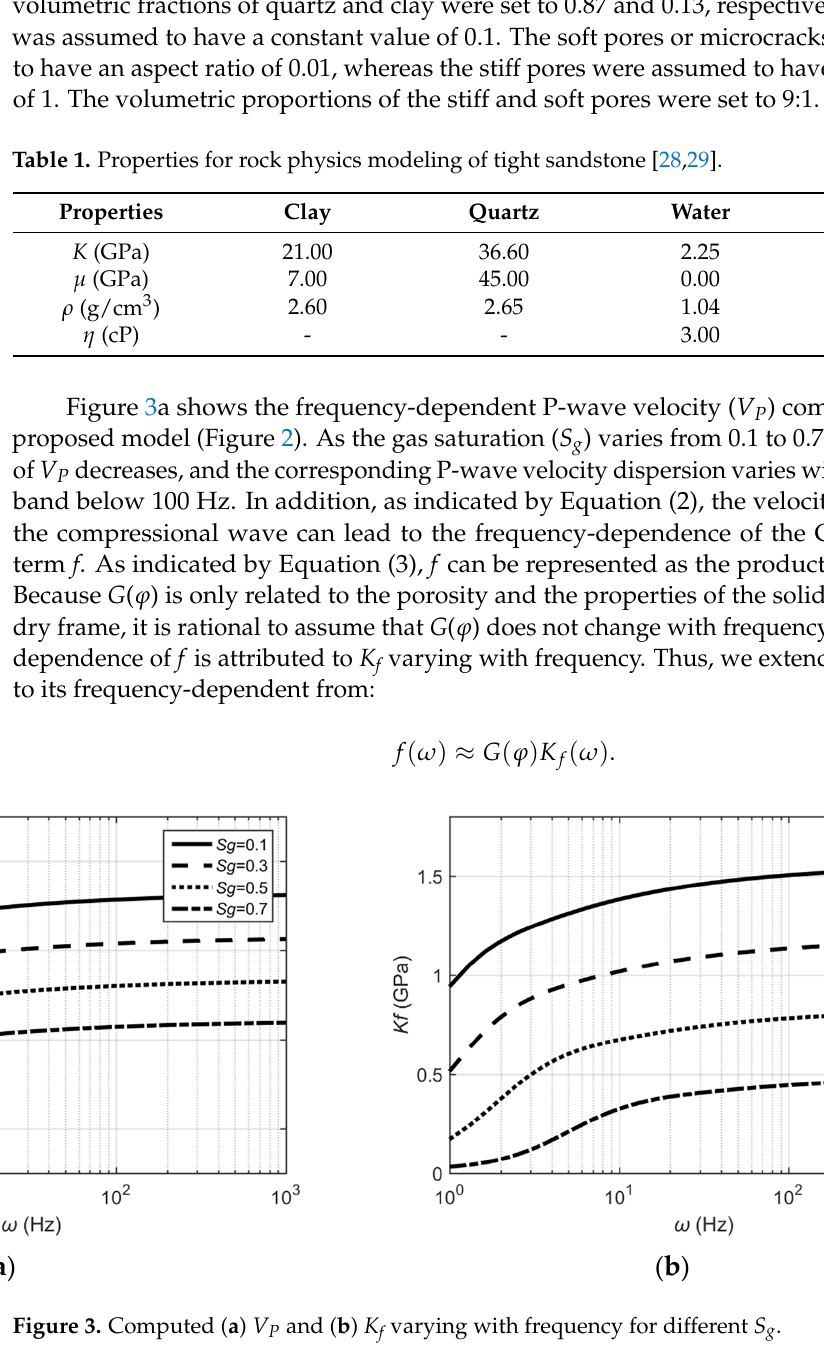
( b ) Figure 4. Computed ( a ) Δ V P / V P and ( b ) Δ K f / K f varying with frequency for different S g . In this study, we assumed that the fluid dispersion attribute was associated with the wave ‐ induced fluid flow described by patchy saturation theory [30]. However, depending on the characteristics of tight sandstones in specific areas, complex poroelastic behaviors in tight sandstones may be described by different theories, including the multi ‐ scale frac ‐ ture model [10,11] and the double ‐ porosity model [12–14]. 3.2. Synthetic Data Test Using a Realistic Model To accurately evaluate our proposed D Kf for gas prediction, we utilized synthetic data for a realistic model based on logging data from the study area. The main challenge faced in applying the realistic model is rock physical and seismic modeling that simultaneously